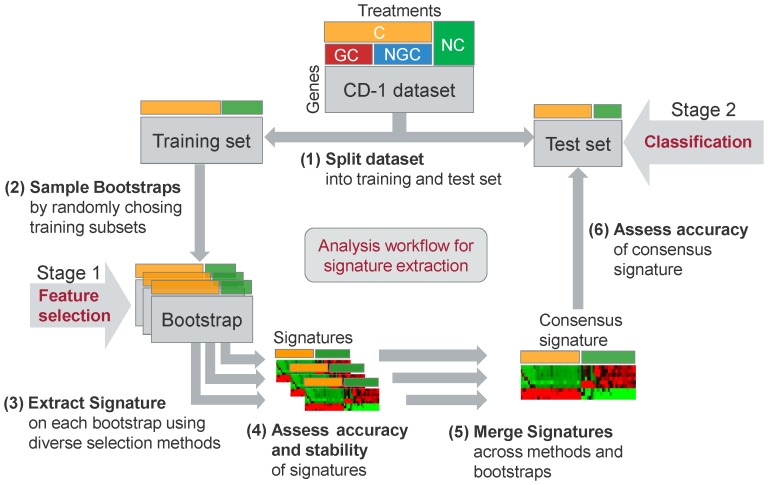
Overview of analysis workflow used for signature extraction and class prediction.The methodology used for the extraction of gene expression signatures is illustrated using our analysis of the CD-1 mouse dataset as example. This dataset contains mRNA expression data from male and female mice treated with GC, NGC, and NC. In the example a signature for the discrimination of C from NC is predicted using the analysis workflow shown above. (1) A stratified cross-validation is performed on the whole dataset. In each cross-validation fold the dataset is split into a training set and a test set. (2) n = 25 bootstraps, each containing 90% of the training samples, are randomly chosen from the training data. (3) A signature, i.e., a subset of informative genes for compound class discrimination is selected on each bootstrap by using m = 4 different methods. (4) The mean classification performance achieved by each gene selection method is computed on the 10% out-of-bag samples, which are left out for each bootstrap. The stability of the consensus signature is assessed by computing the Kuncheva index from the list of signatures extracted from different bootstraps. (5) The n×m signatures selected by m methods on n bootstraps are merged, based on a joint ranking computed from the sums of the ranks calculated for individual signatures. (6) Various machine learning algorithms are employed to predict the carcinogenic compound class, based on the inferred consensus signature. The performance is evaluated on the independent test set and assessed in terms of area under the ROC curve.